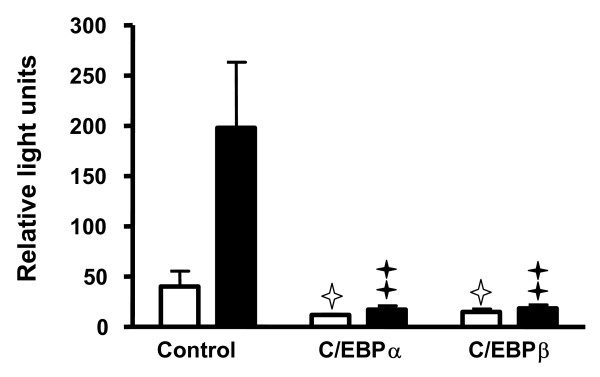
Inhibition of promoter/enhancer activity of PSA by human C/EBPα and C/EBPβ. The LNCaP cells were transfected either with human C/EBPα or C/EBPβ and the full-length PSA promoter coupled to the luciferase reporter. Luciferase activity was measured in the presence (dark bars) or absence (open bars) of DHT as described in Figure 4. The results expressed as relative light units are the means ± standard deviation of 3 separate experiments. The open and dark double stars represent P values as described in Figure 4A.